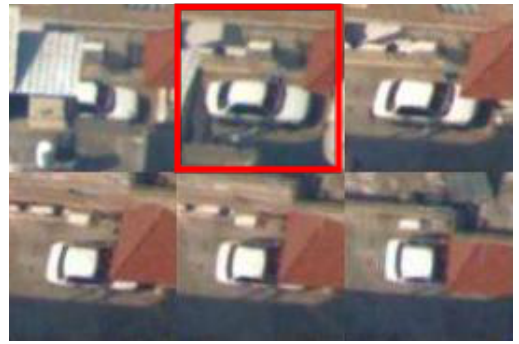
Figure 3: Example of multiple views with large baseline and various levels of visibility. Images were rotated to align with the x axis and only fully visible examples are used during training (marked in red).